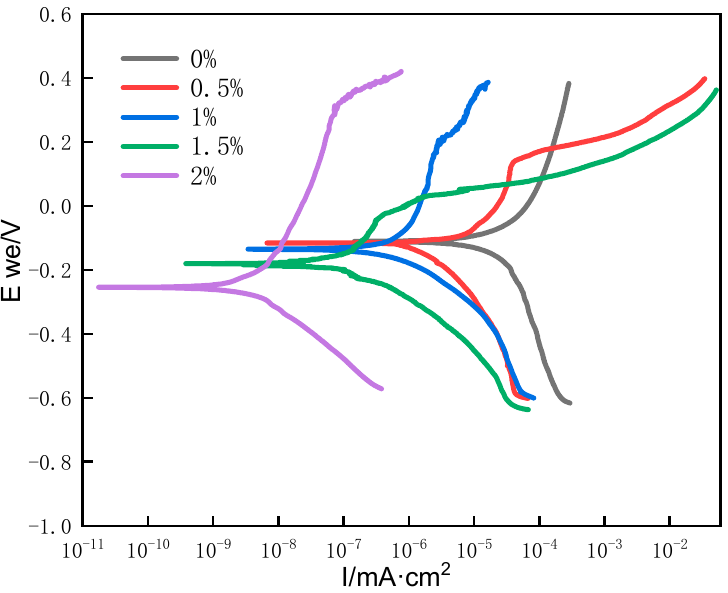
Figure 6. Comparison of polarization curves of surfacing layers with different boron additions. Table 5. Electrochemical corrosion results of surfacing layer with different boron content. B Addition (%) Self Corrosion Potential (V)